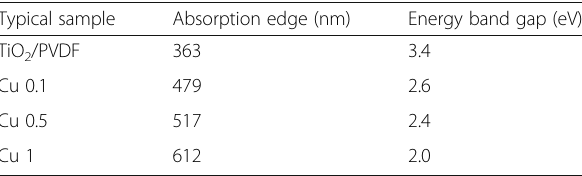
Table 2 Absorption edge and energy band gap of TiO 2 /PVDF, Cu 0.1, Cu 0.5, and Cu 1 samples